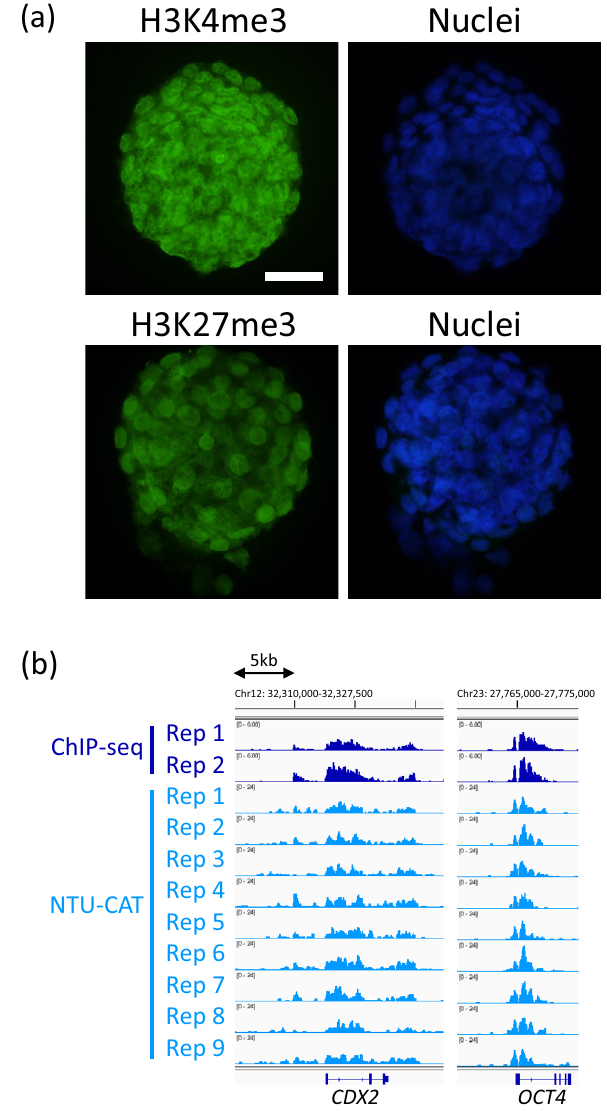
Figure 3. Permeability of antibodies in NTU-CAT. ( a ) Immunofluorescent images of H3K4me3 (upper, left) and H3K27me3 (lower, left) assessed by replacing the secondary antibody with a fluorochrome-conjugated antibody are shown alongside the nuclear counter-staining by Hoechst 33342 (right). Scale bar represents 50 µm. ( b ) Snapshot of the H3K4me3 landscape at CDX2 and OCT4 . The NTU-CAT-derived peaks in nine replicates were visualized using Integrative Genomics Viewer 29 alongside the peaks from our previous ChIP-seq analysis of a cohort of blastocysts 11